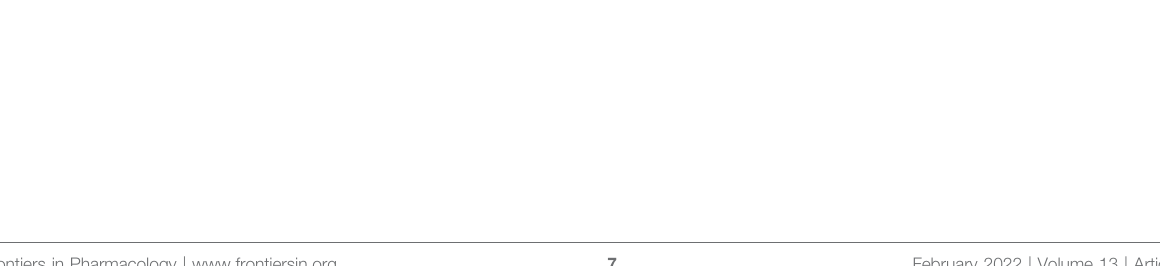
Frontiers in Pharmacology |